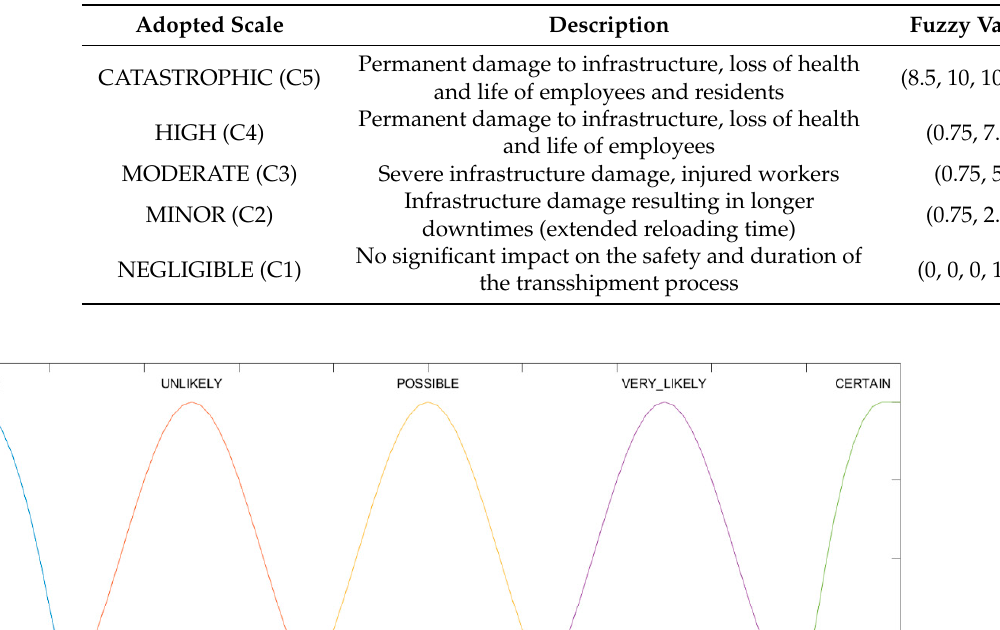
Table 5. Consequences of scenario occurrence.